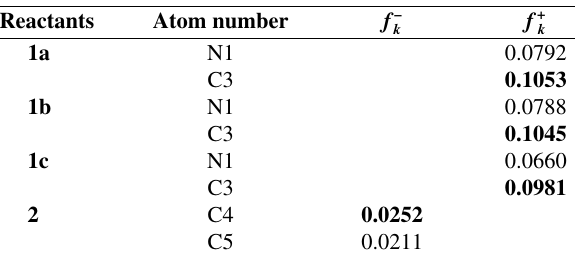
Table 3. Fukui indexes for N1 and C3 atoms of the dipoles 1a–c and for atoms C4 and C5 of the dipolarophile 2 .